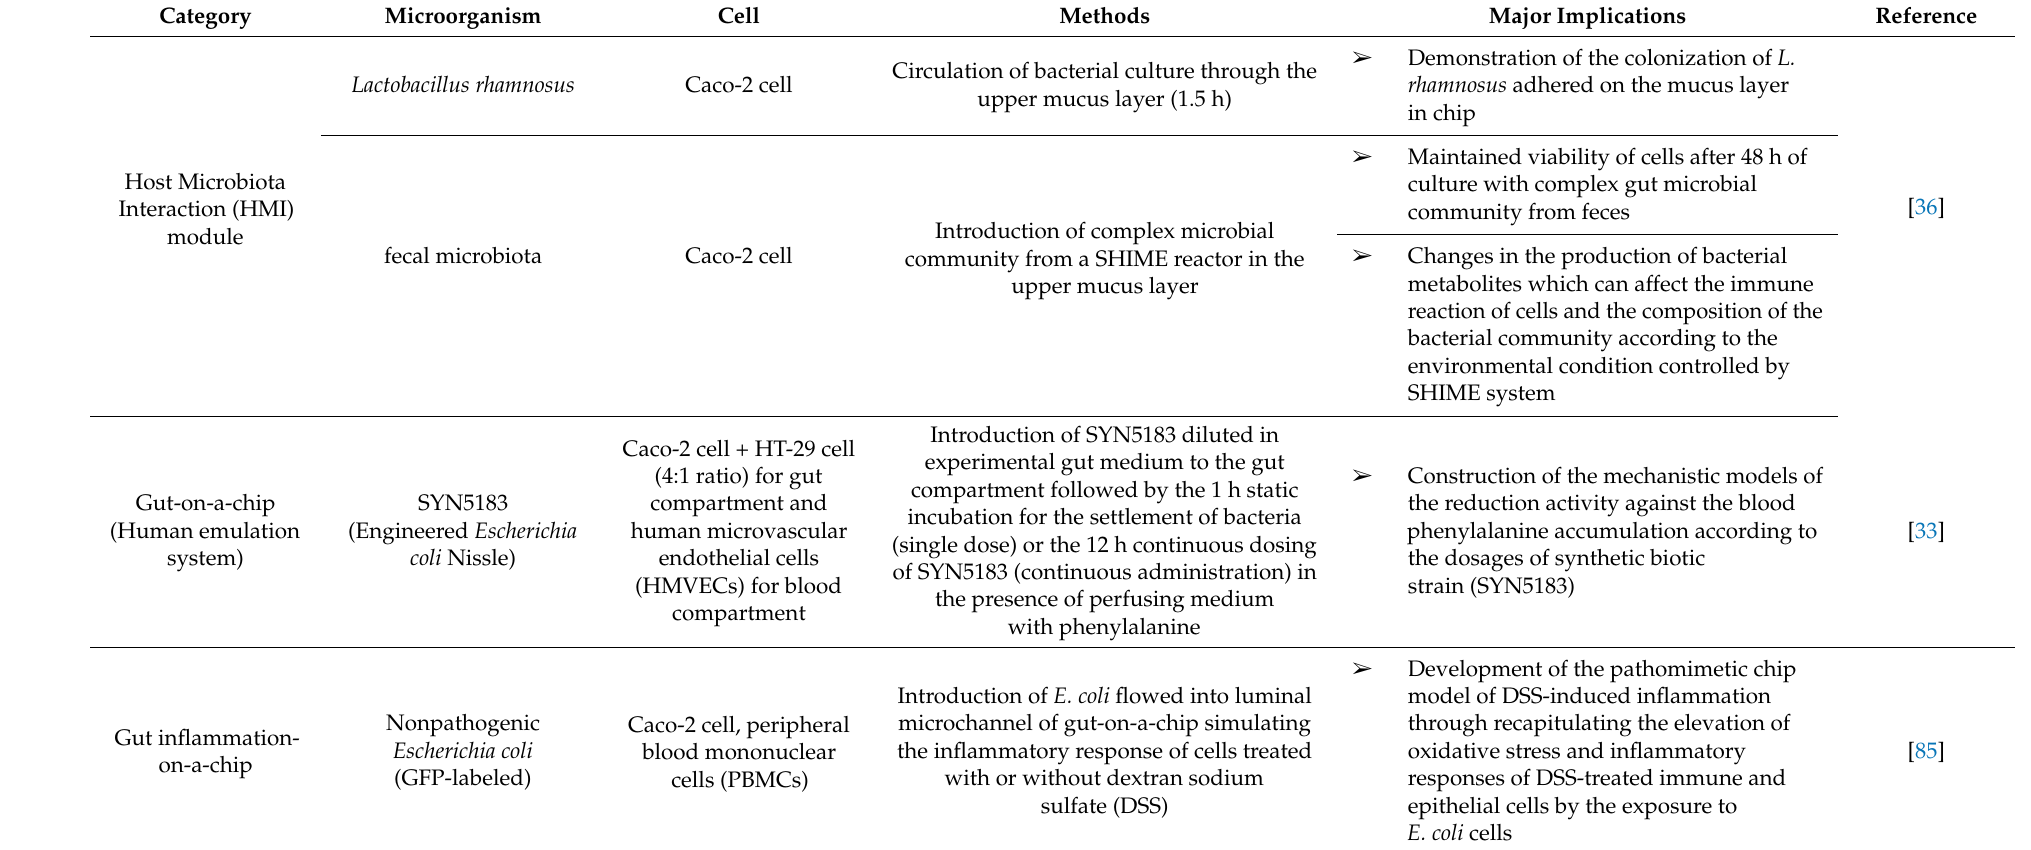
Table 4. Methods and implications from the results of bacterial culture in the gut-on-a-chip as an organ simulation